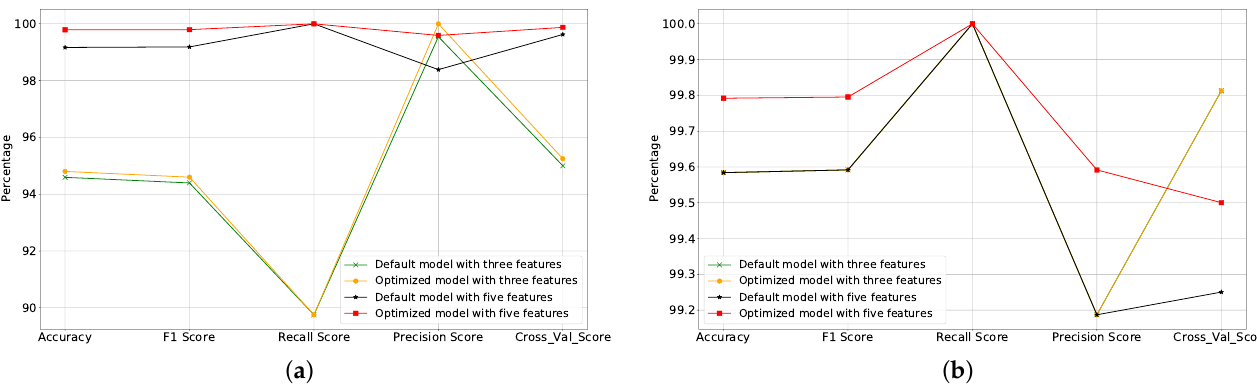
Figure 11. Performance evaluation of LR and KNN algorithms: ( a ) LR algorithm; ( b ) KNN